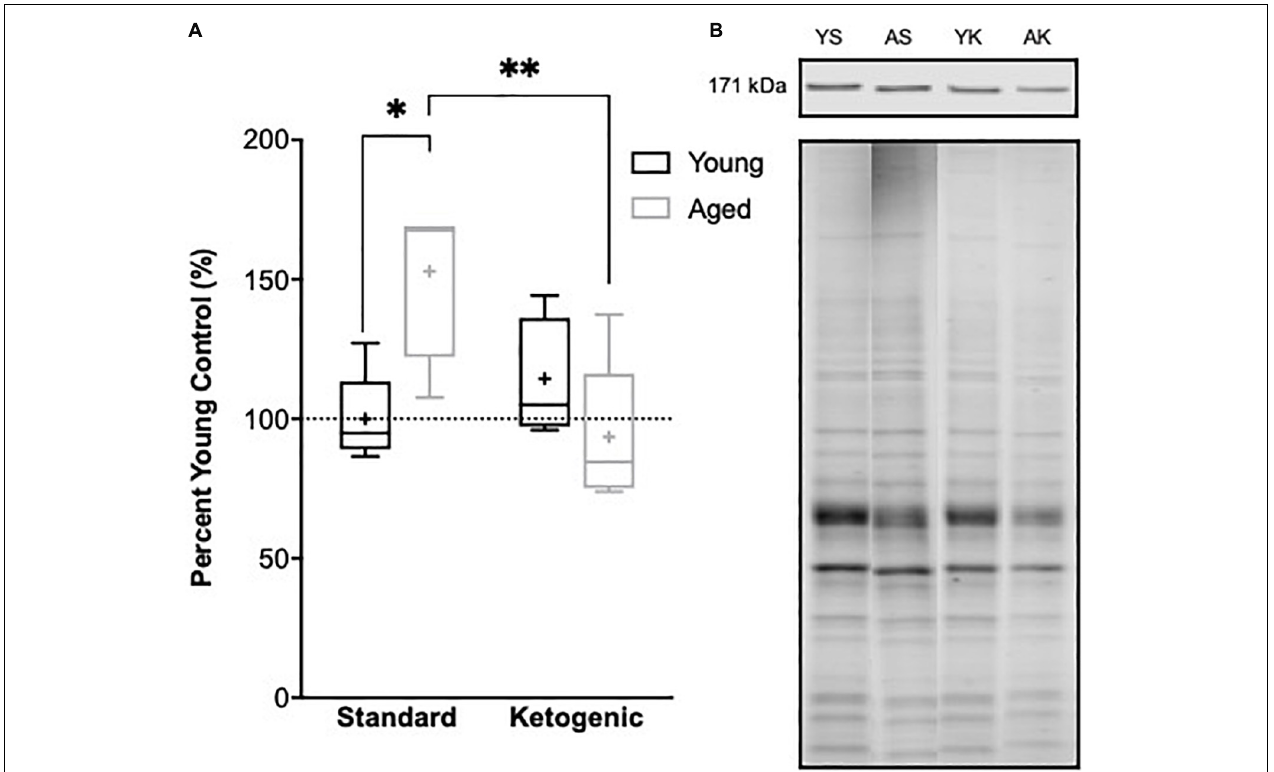
FIGURE 7 | Hippocampal ROCK2 protein expression. (A) Aged rats demonstrated significantly higher levels of ROCK2 expression in the hippocampus relative to young standard-fed (SD) rats, but levels were restored to that of the young SD-fed rats in ketogenic-fed (KD) aged subjects. (B) Representative ROCK2 bands (top), which were then normalized to total protein stains (bottom) to account for variability in total protein loading. Note total protein was less in aged compared to young animals. Boxes represent the upper and lower quartiles around the median, the whiskers are the minimum and maximum observed values and + indicates the group mean. All values are expressed as percent of young SD-fed controls (dotted line). ∗ indicates a significant effect of age across standard-fed subjects and ∗∗ indicates a significant effect of diet across aged